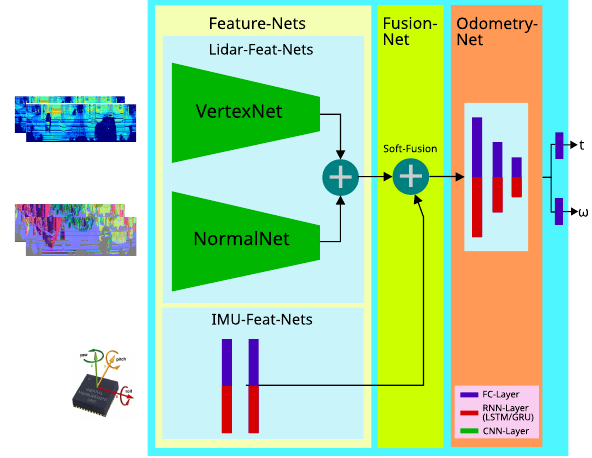
Figure 2. Architecture overview and data stream of the proposed DeepLIO